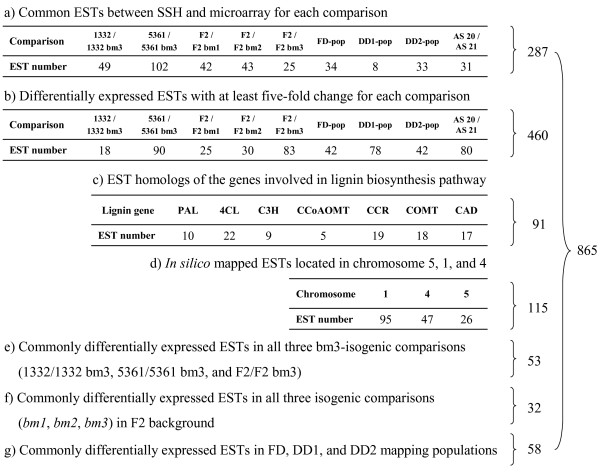
Selection of 865 candidate ESTs for cell wall digestibility based on seven selection criteria.